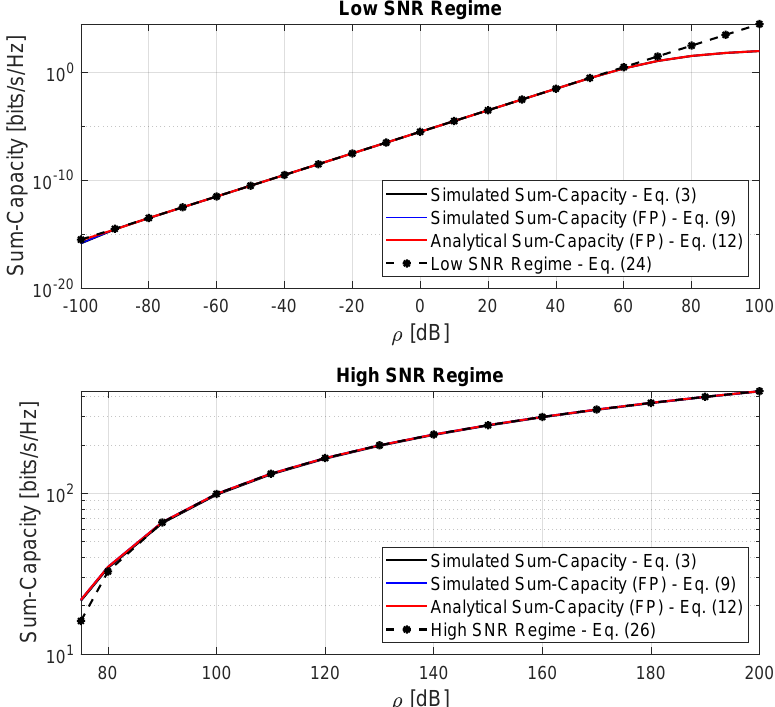
Figure 4. Sum-capacity for low- and high-SNR regimes versus average signal-to-interference ratio, ρ